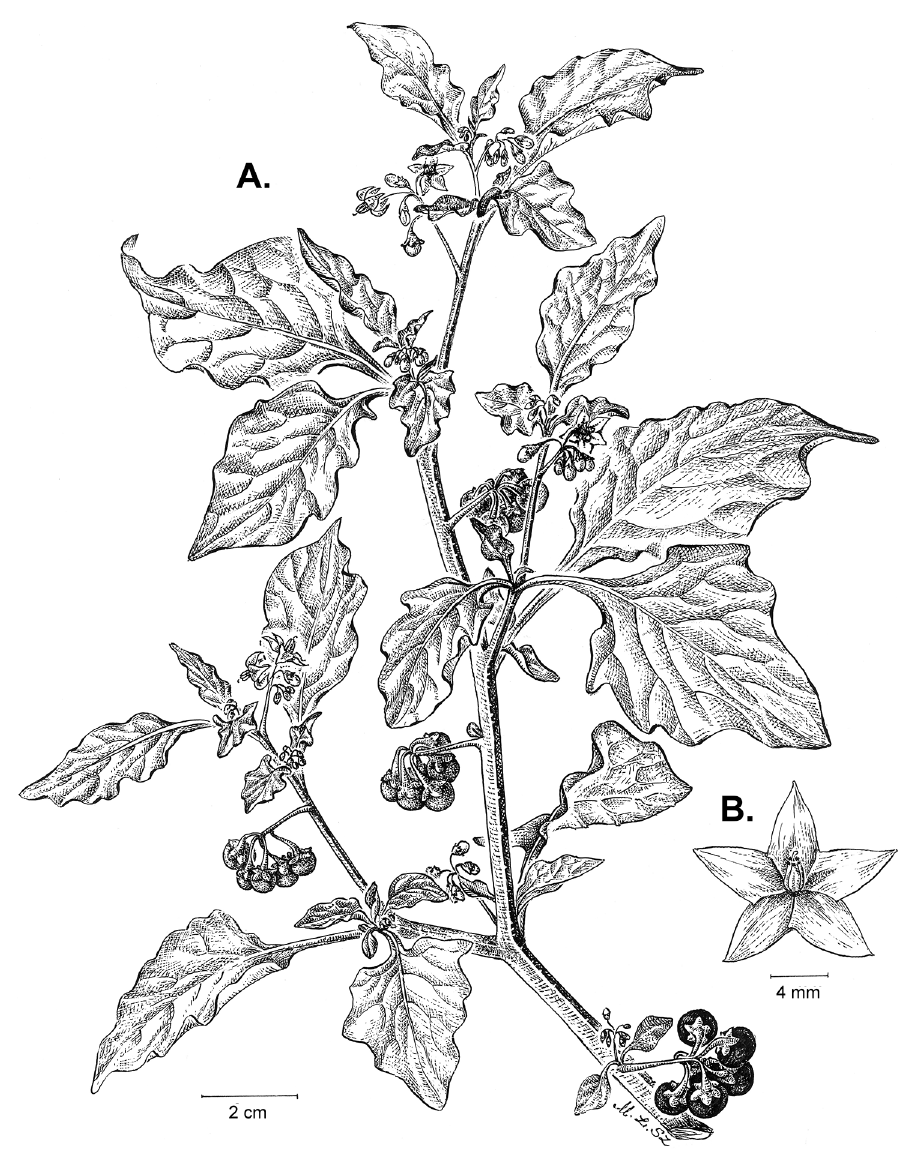
Figure 30. Solanum nigrum L. A Habit B flower ( A ,B Symon 5449 [ADW 35964]). Drawing by M.L. Szent-Ivany, first published in Symon (1981), courtesy of the Board of the Botanic Gardens and State Herbar- ium (Adelaide, South Australia), reproduced with permission (previously also published in “PhytoKeys